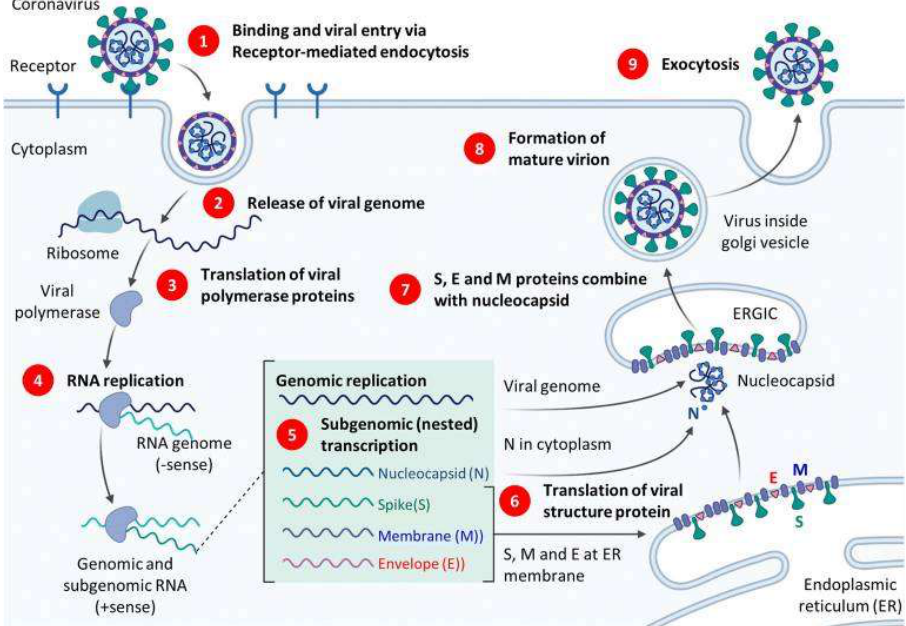
Figure 2. Illustration of SARS-CoV-2 replication cycle. Reproduced from [43] under the Creative Commons Attribution 4.0 International License.